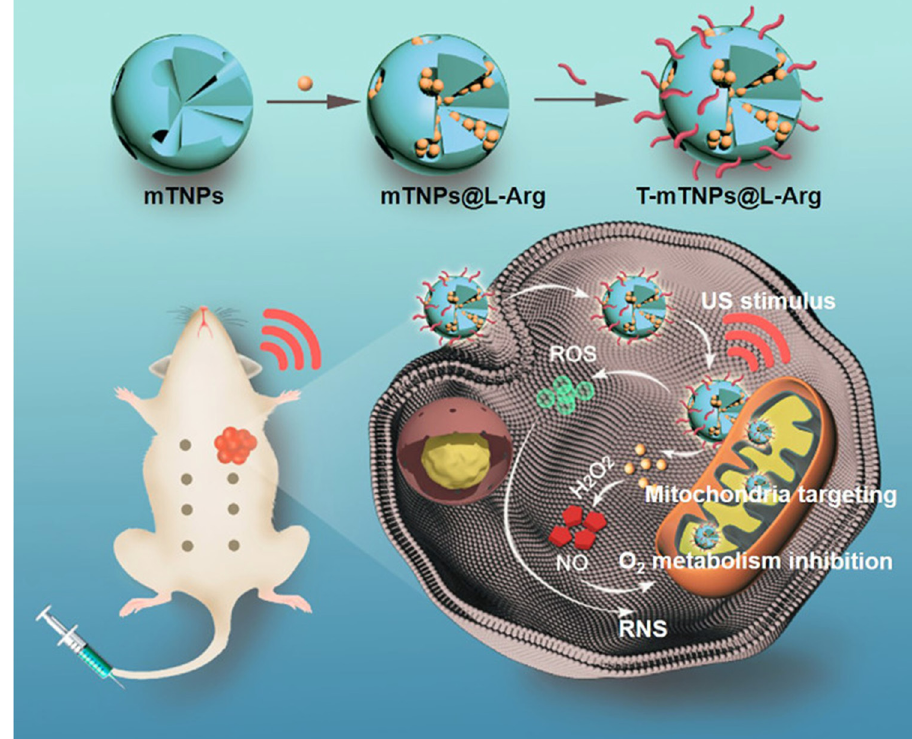
Figure 6: HMTNPs target mitochondria with nitric oxide gas. Reprinted ( adapted ) with permission [ 40 ] . Copyright © 2022 Zuo et